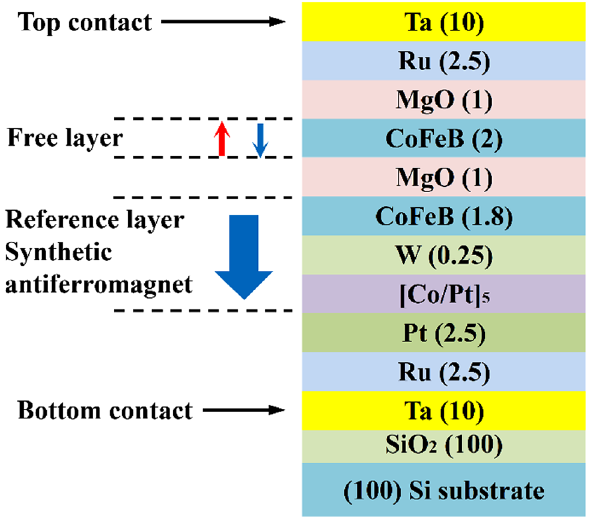
Figure 1. Structural schematic diagram of the spin transfer torque film stacks. Numerical numbers in parentheses represent the nominal thickness of each layer in nanometers except for (100) Si substrate crystal